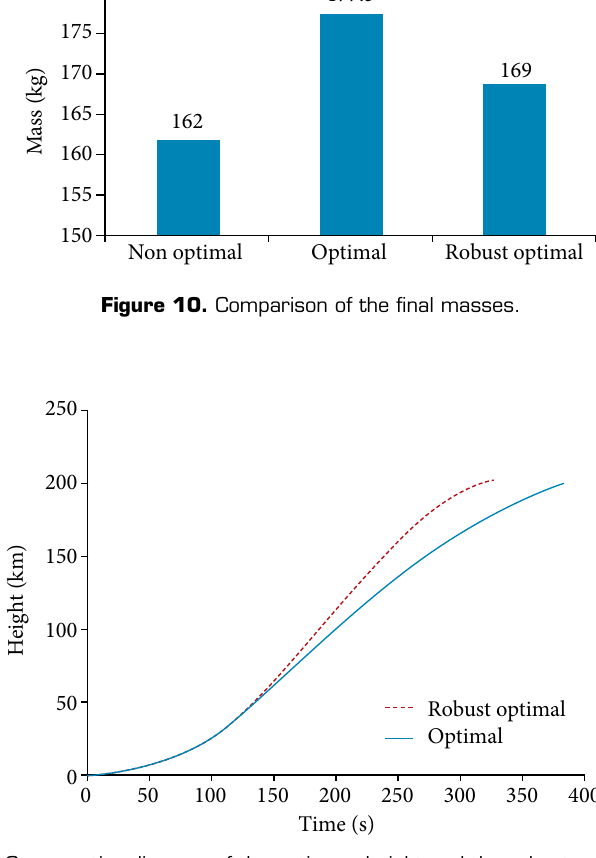
Figure 11. Comparative diagram of the optimum height and the robust optimum height.